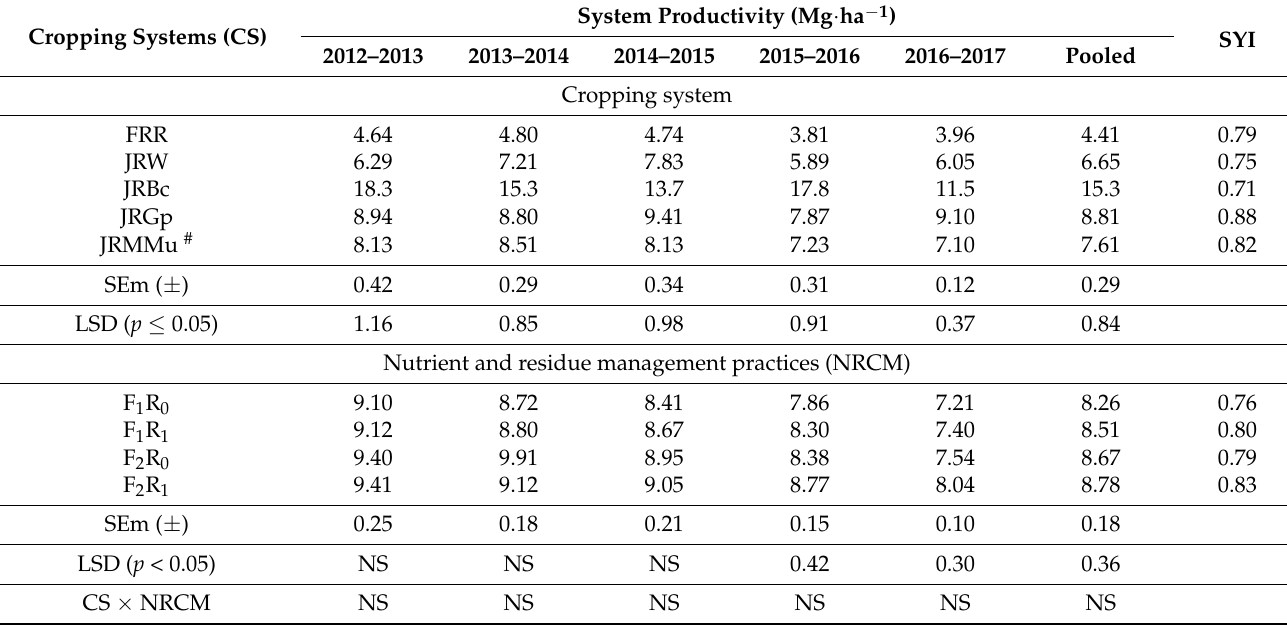
Table 1. System productivity and sustainable yield index (SYI) of different cropping systems under nutrient and crop residue management